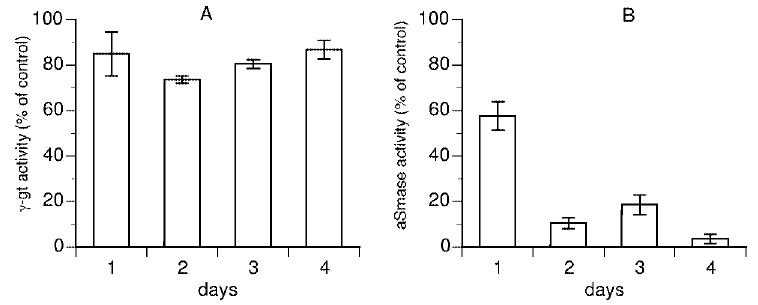
Fig. 1. A: Time–course of membrane γ -glutamyltransferase activity during apoptosis induced by 1 µ M calcimycin. B: Time–course of acidic sphingomyelinase activity during apoptosis induced by 1 µ M calcimycin. Results (%) are means ± one SD of three separate experiments. The absolute specific activity of the γ -glutamyltransferase and acidic sphingomyelinase in untreated SK-BR-3 cells (24 h) is 24.1 nmol/min/mg and 2.4 nmol/h/mg,